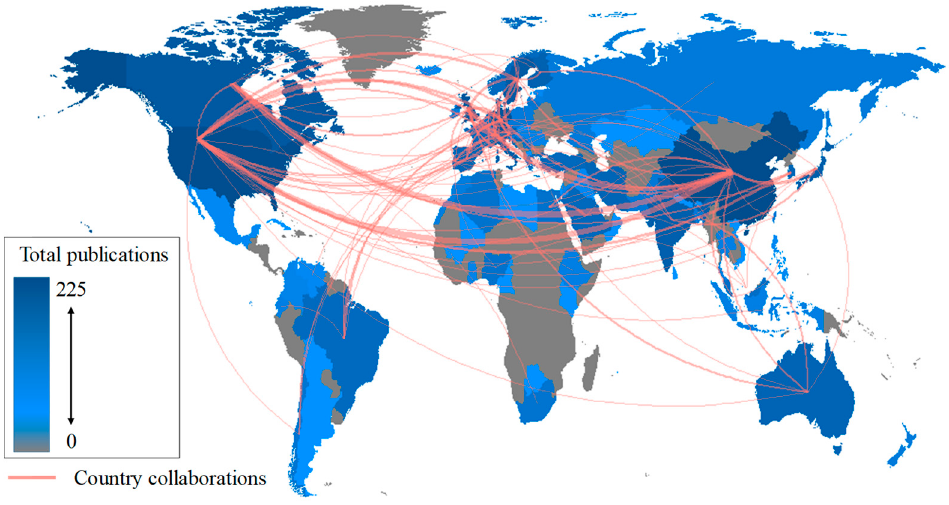
Figure 1. World map collaboration on municipal energy system planning. The blue gradient shows the number of publications and the red lines represent collaborations between countries. The illustration was in part created with the R-tool bibliometrix [9].